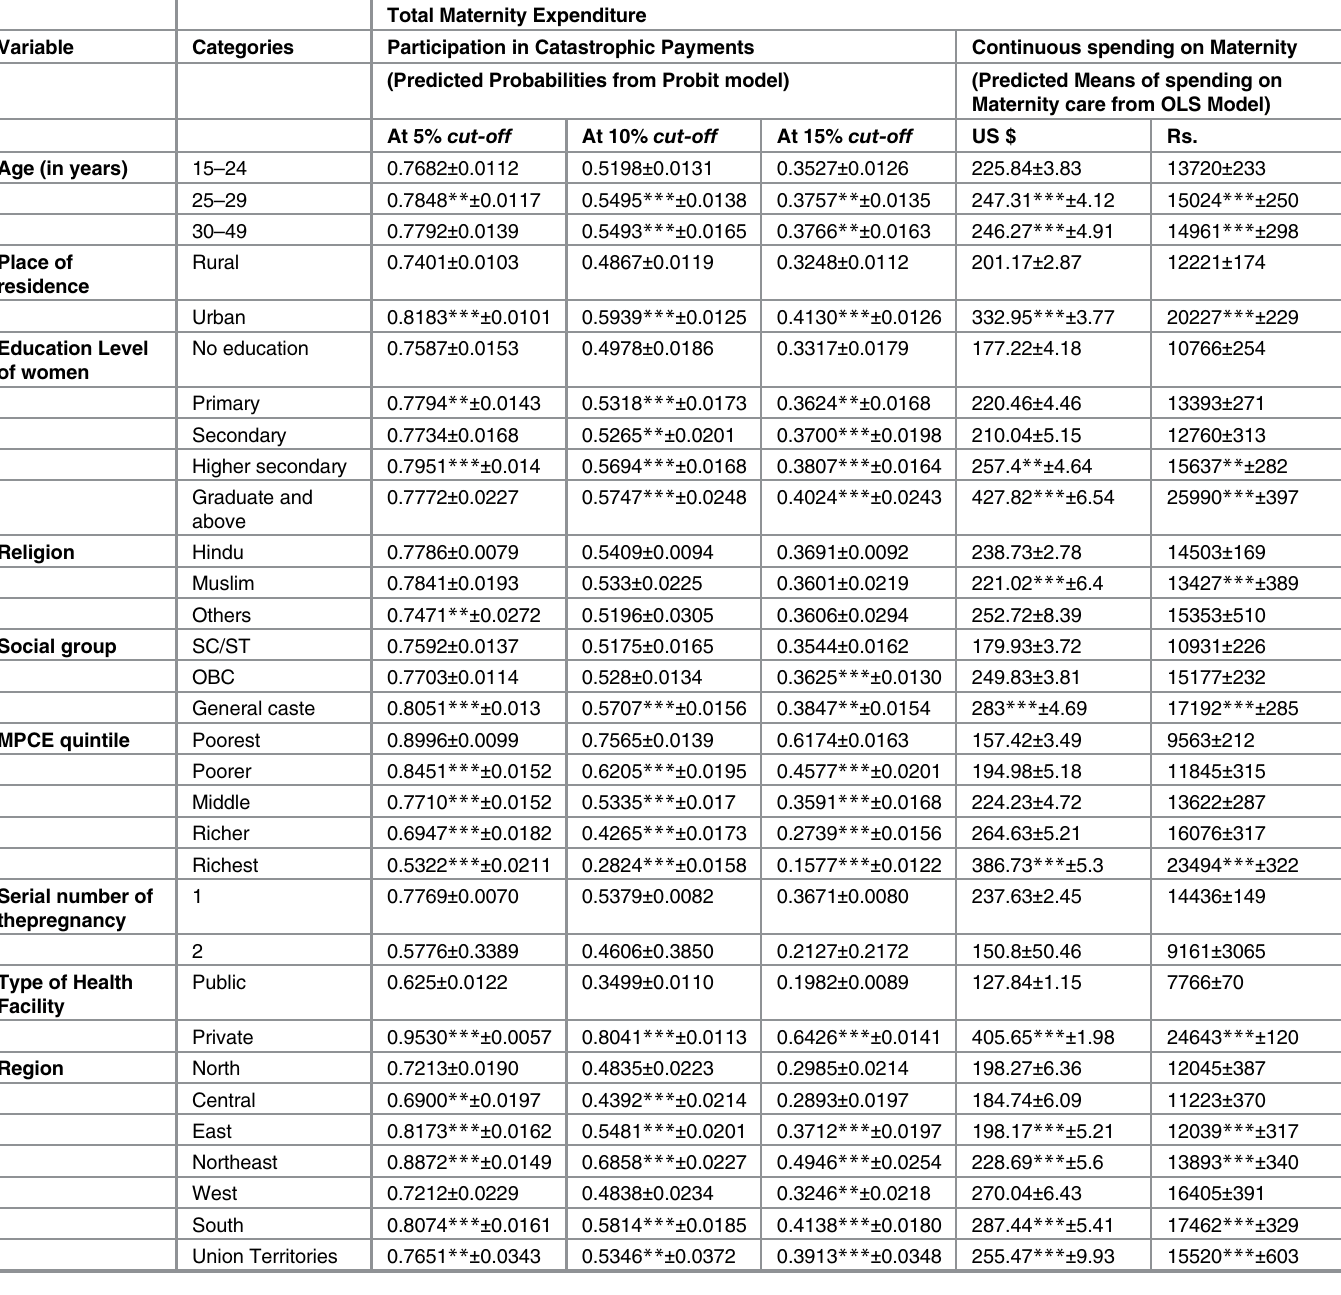
Table 4. Two part model estimates showing the factors affecting the total maternity expenditure in different cut-offs ( n = 10379). Total Maternity